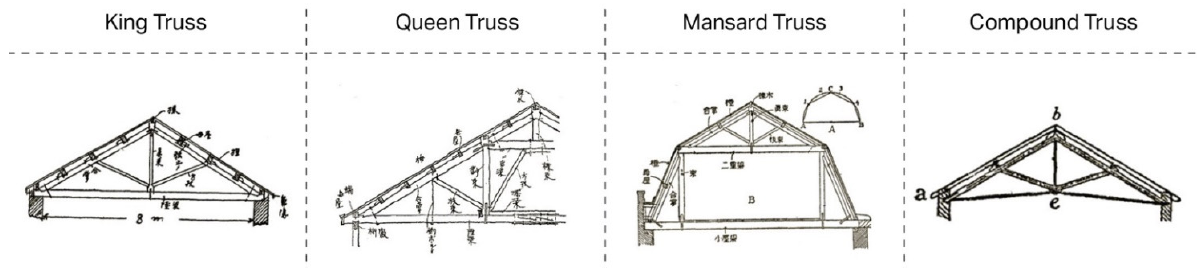
Figure 12. Four Types of Western Roof Truss Shown in Japanese Books on Modern Building Tech- niques (Lin and Kim) [9].